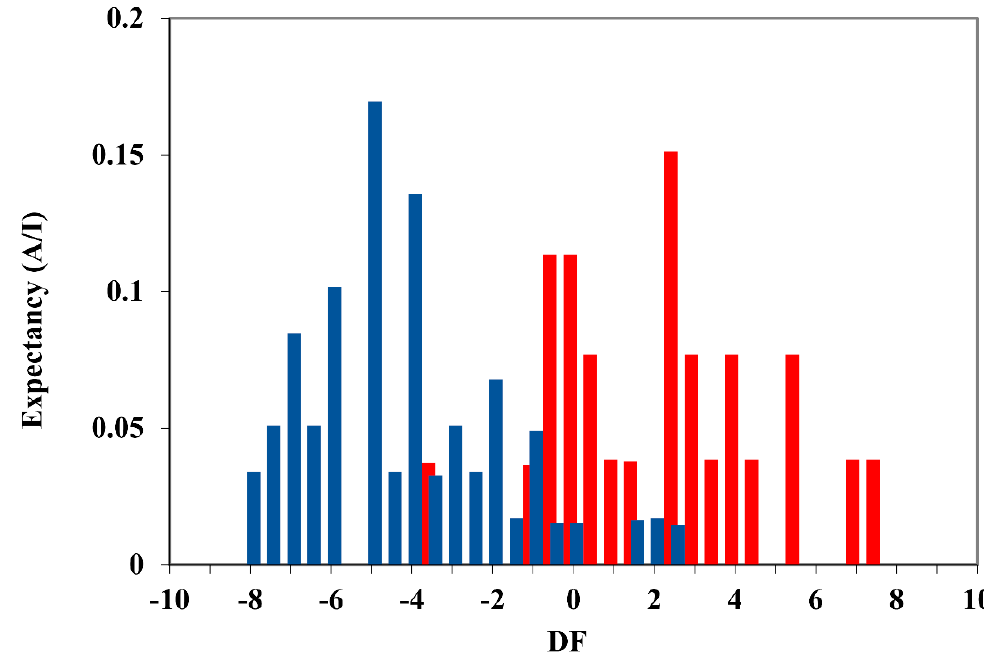
Figure 2. Pharmacological distribution diagram for bonding affinity, k i , (red columns represents activity, and blue columns inactivity).